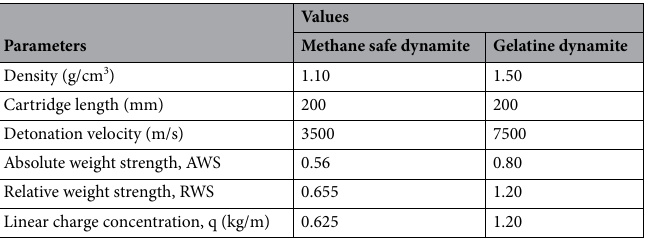
Table 3. Technical properties of methane safe permissible and gelatine type dynamites 33